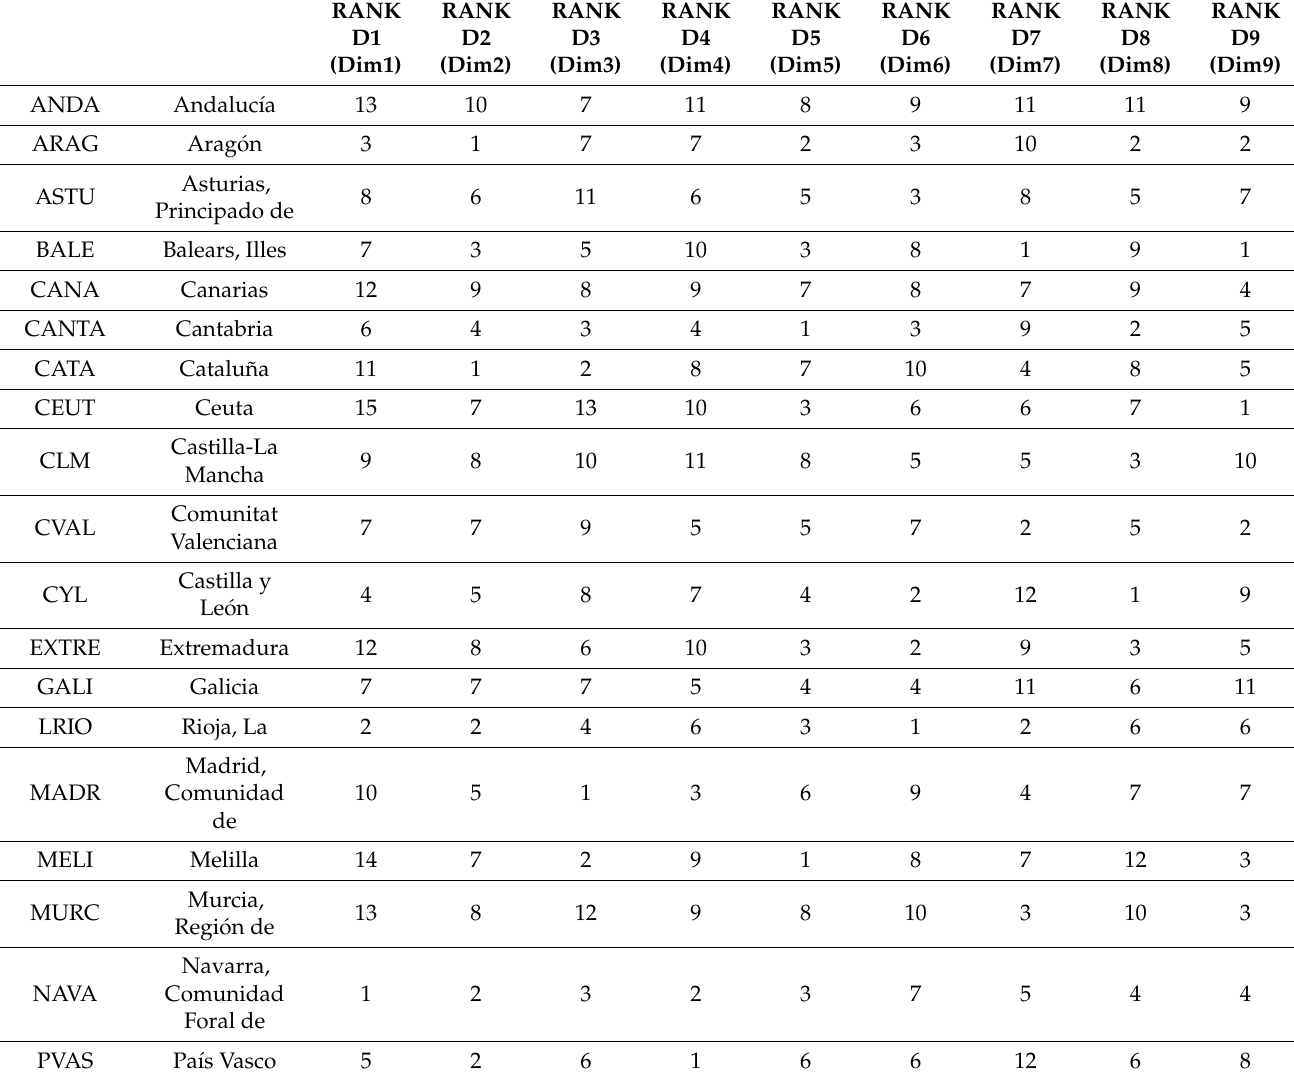
Table 6. The ranks for the nine dimensions obtained with ELECTRE III from the original INE